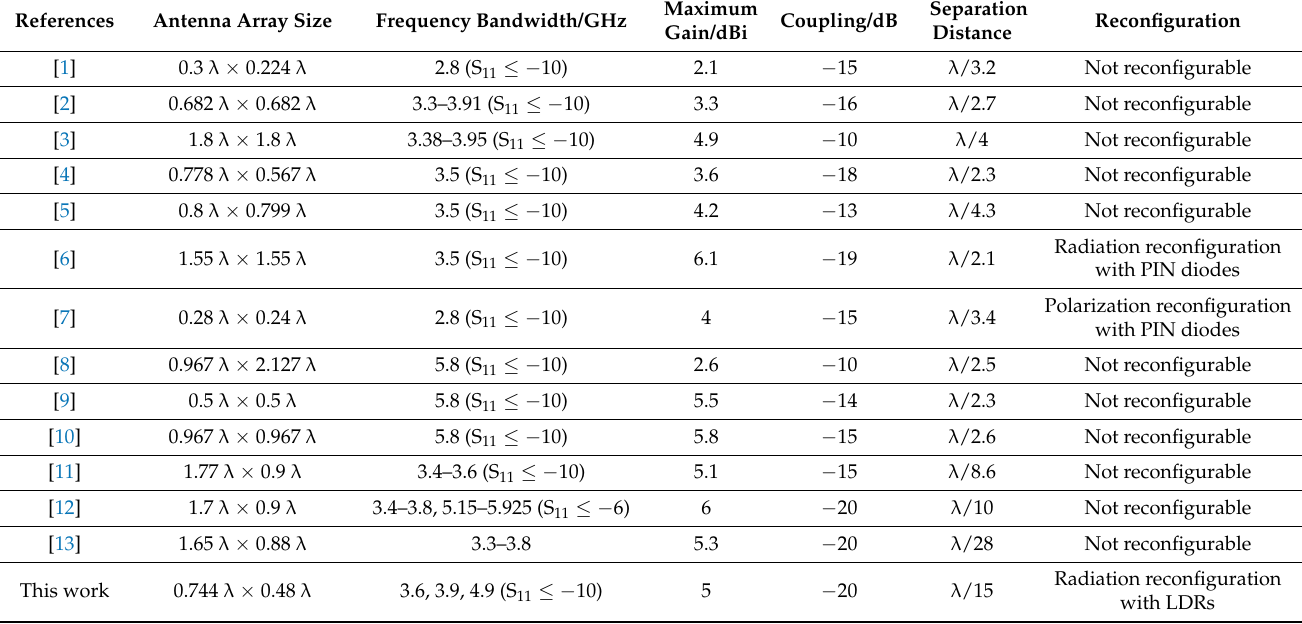
Table 2. Antenna performance with respect to the published